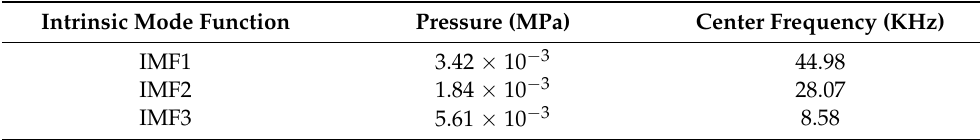
Table 2. Center frequency and pressure amplitude of each IMF component of in-cylinder pressure